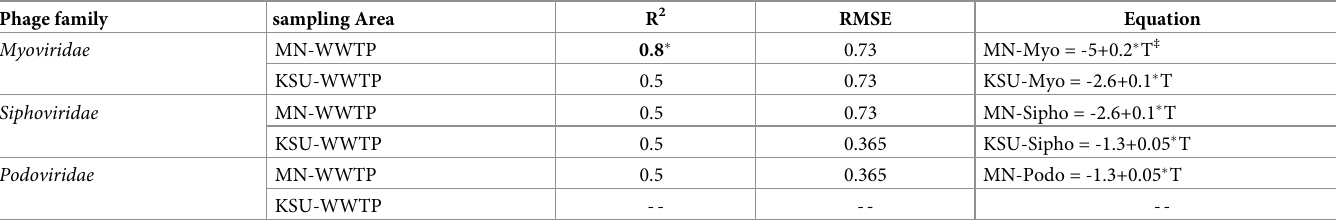
Table 3. The significance of the influence of temperature on prevalence of phage families in wastewater treatment plants.